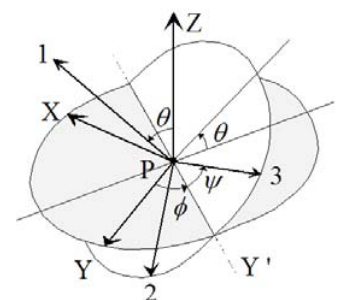
Figure 1: Principal stress directions 1 , 2 , 3 described through the Euler angles  ,  , 